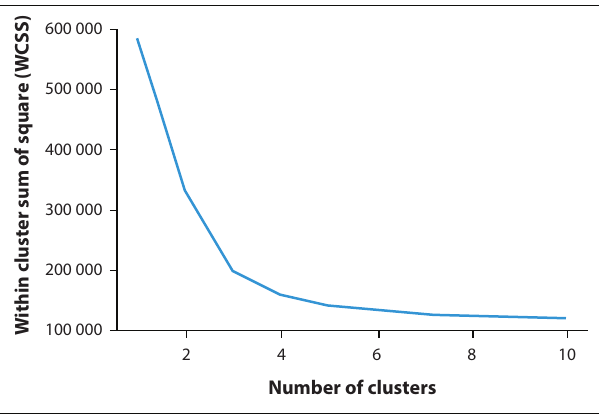
FIGURE 6: The elbow plot for optimal cluster selection.